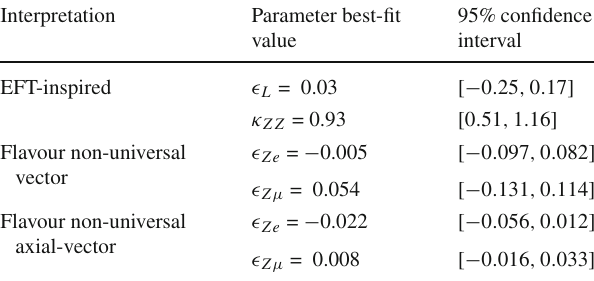
the data and the m 12 vs. m 34 prediction corresponding to the best-fit values of the parameters of interest for each of the four scenarios con- sidered. The SM predictions ( ∗ ) and the observed best-fit values (+) are indicated on the plots Table 8 Confidence intervals for the scenarios considered in the pseudo-observables framework. Based on the observed 2D exclusion contours, 1D exclusion intervals are provided for the EFT-inspired, flavournon-universalvector,andflavournon-universalaxial-vectorsce- narios. The observed limits are calculated while profiling the other parameters of interest. For the EFT-inspired interpretation, the limits are derived assuming κ ZZ ≥ 0. This constraint has no impact on the limit as the analysis is not sensitive to the sign of this